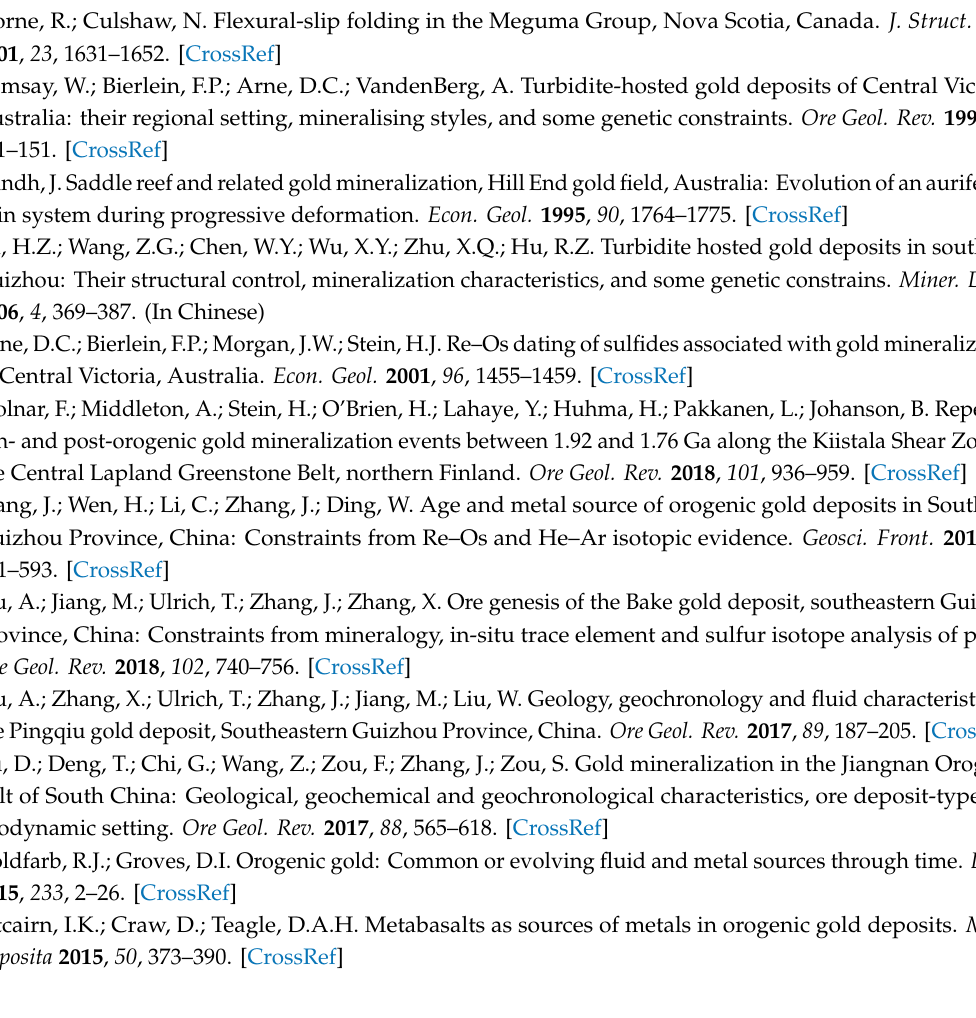
Table S1. LA-ICP-MS zircon U–Pb dating of the host rocks and gold-bearing quartz veins from the Chaoyangzhai gold deposit. Table S2. Major and trace element compositions of the rocks from the Chaoyangzhai gold deposit. Table S3. Ore-forming element contents of the ore (ppm). Table S4. Sulfur isotopic compositions of the sulfides from the Chaoyangzhai gold